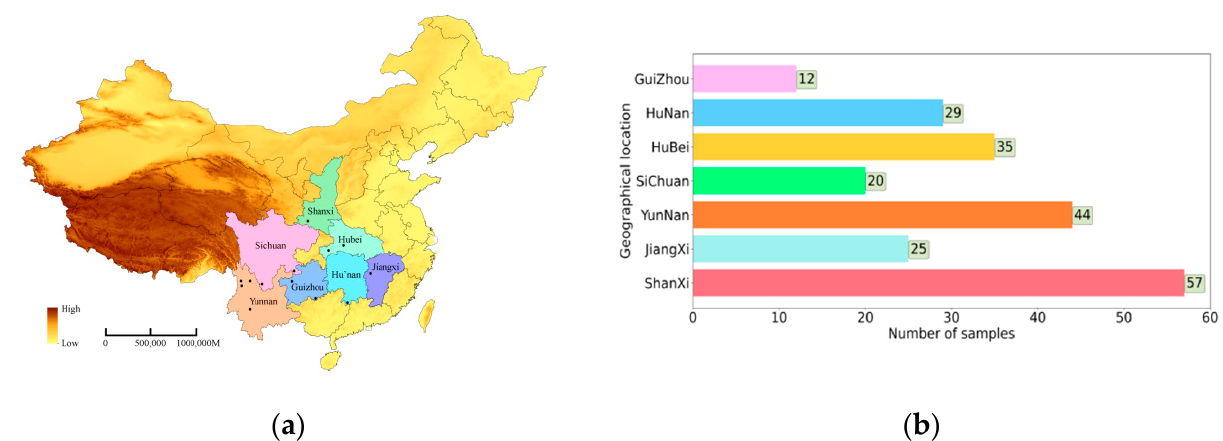
Figure 6. The data sources and data distribution: ( a ) seven geographic sampling locations of wild Gentiana genus samples; ( b ) the distribution of wild Gentiana genus samples in 7 provinces.